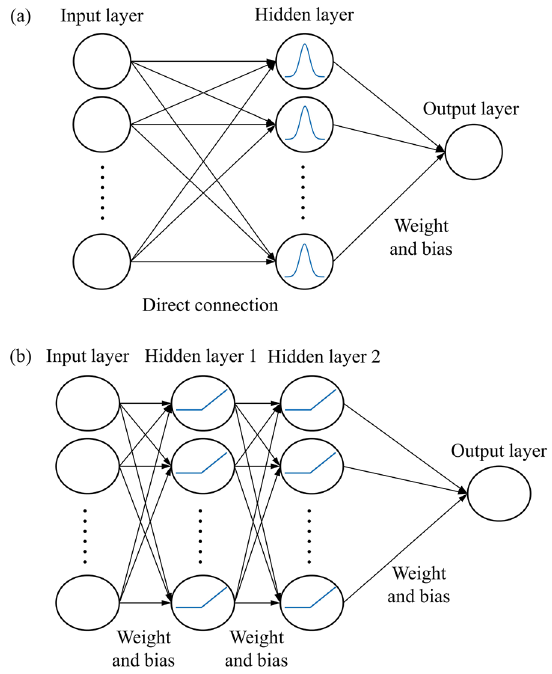
Figure 10 Structure of RBF and BP neural network: ( a ) RBF neural network, ( b ) BP neural network